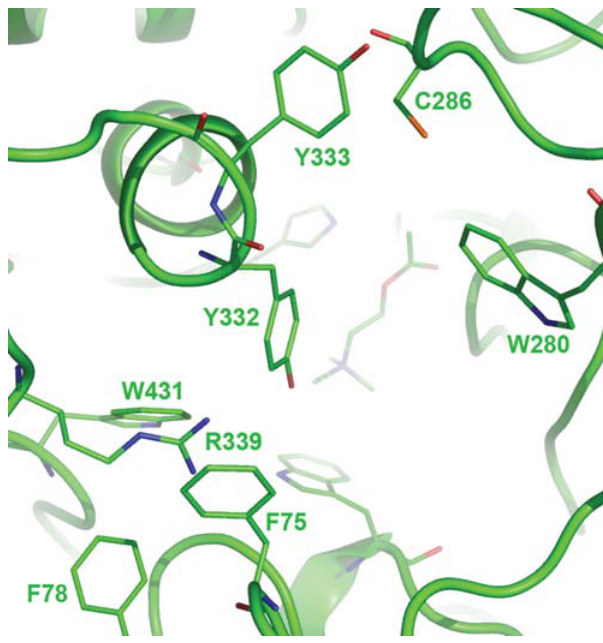
Figure 4. Close-up view of the peripheral site of Anophelesgambiae acetylcholinesterase Perspective: looking down onto substrate acetylcholine at the catalytic